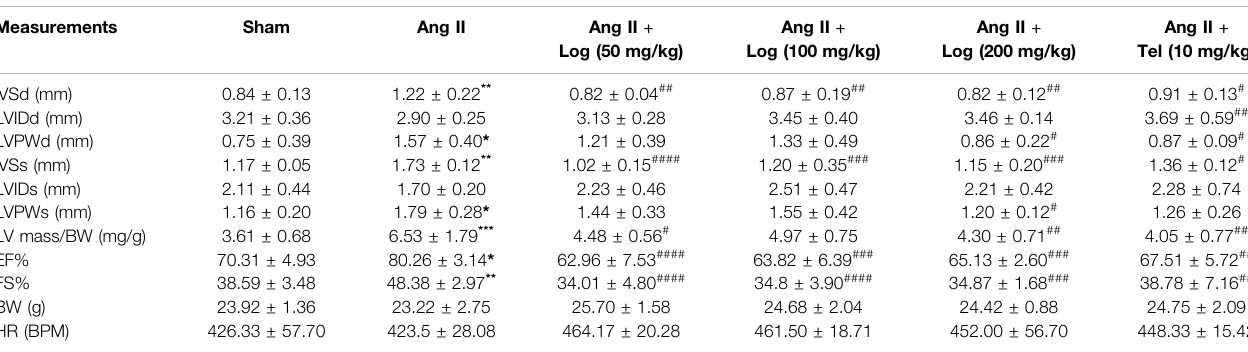
TABLE 1 | Echocardiographic